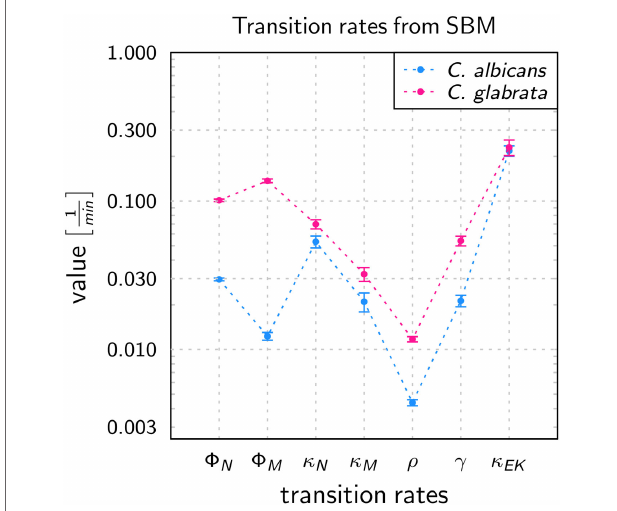
FIGURE 3 | Transition rates obtained from the calibration of the state-based model (SBM) to experimental data of the whole-blood infection assay for Candida albicans (blue) and Candida glabrata (pink), respectively. The values are compared for the phagocytosis rate for neutrophils ( φ N ), and by monocytes ( φ M ), killing rate for neutrophils ( κ N ) and monocytes ( κ M ), the rate at which the pathogens can evade the immune response with regard to phagocytosis and/or killing ( ρ ) as well as the rates that define the extracellular killing, i.e., γ and (cid:22) κ EK . Error bars correspond to